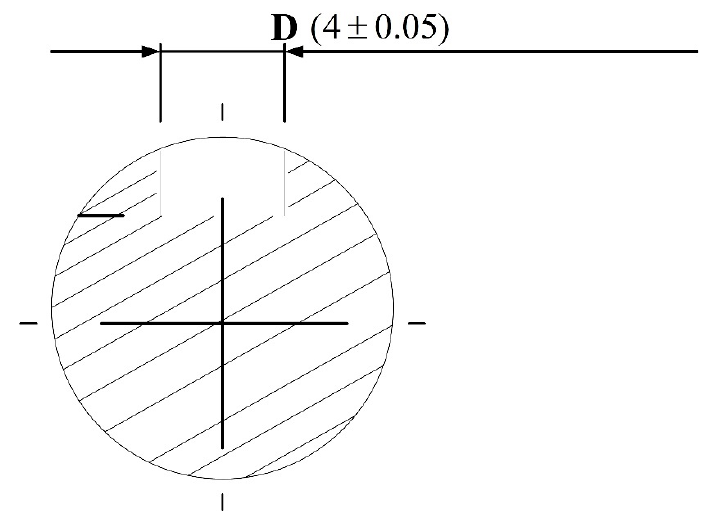
Figure 3. Distance tolerance of groove pitch gap.